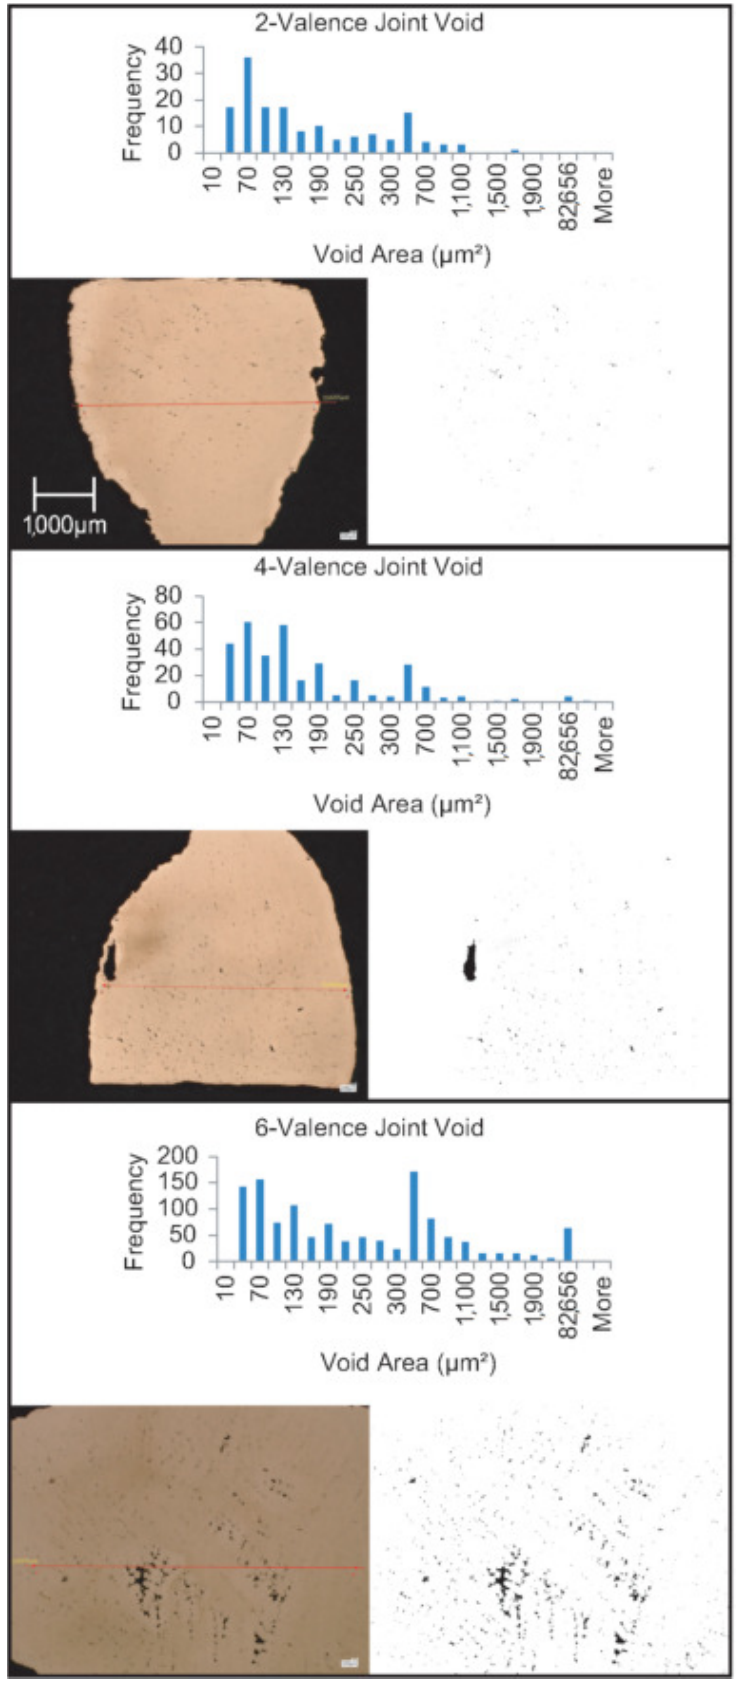
Figure 13. Microscopic analysis for porosity using optical microscopy. Images 50 ×